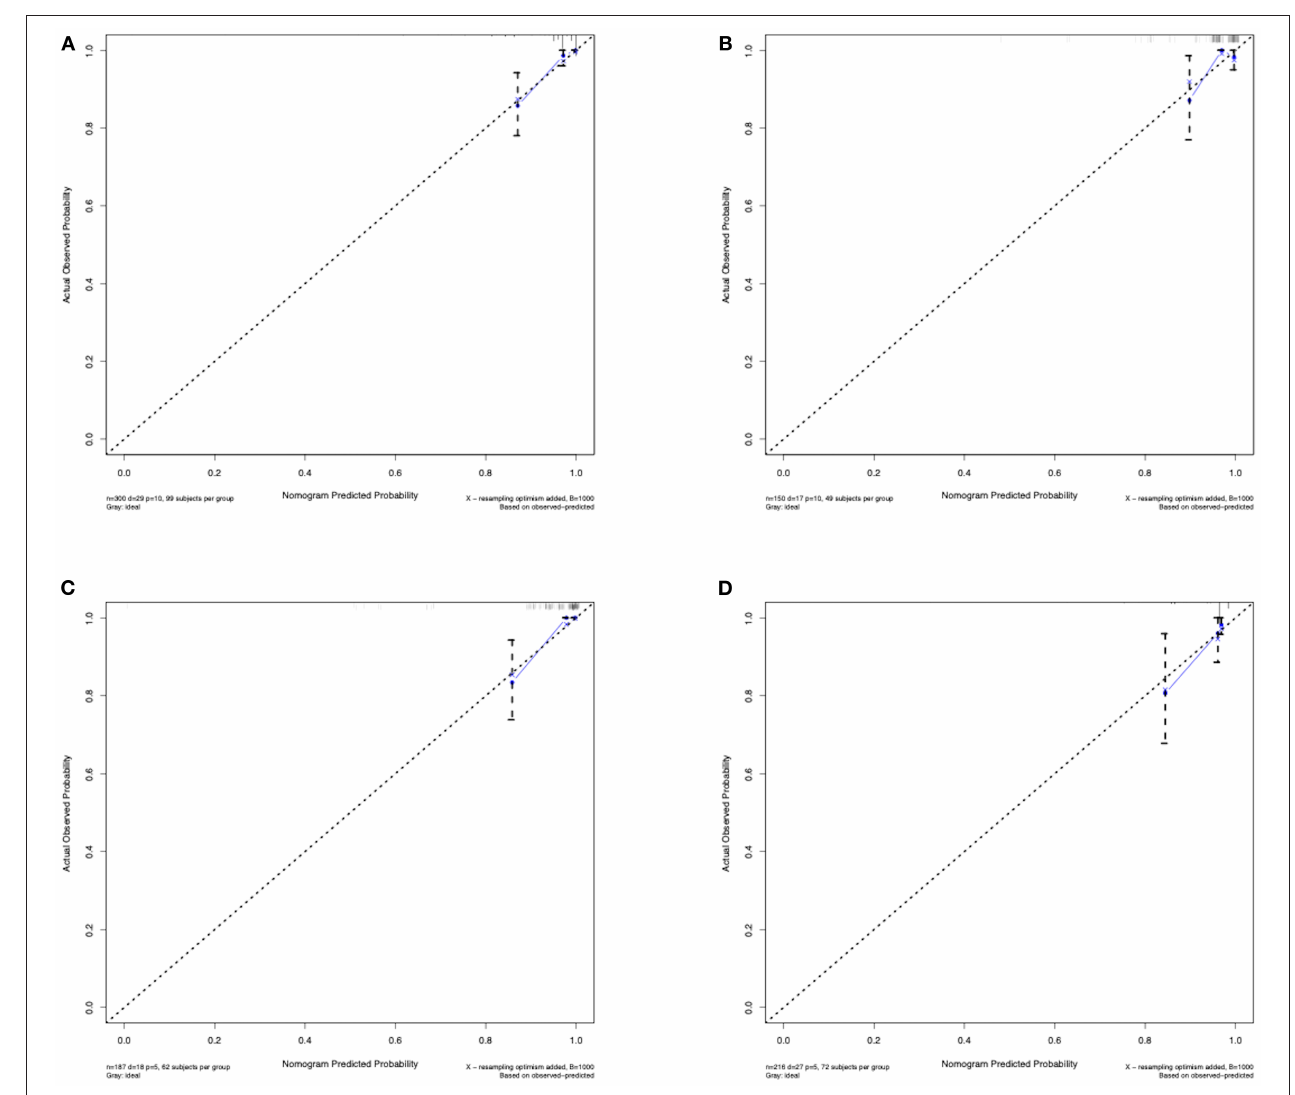
FIGURE 4 | Calibration curves of the predictive nomogram. (A) Calibration curve of the predictive nomogram for 3-year stroke-free survival in the training set. (B) Calibration curve of the predictive nomogram for 3-year stroke-free survival in the test set. (C) Calibration curve of the predictive nomogram for 3-year stroke-free survival in the ischemic-type group. (D) Calibration curve of the predictive nomogram for 3-year stroke-free survival in the hemorrhagic-type group. Calibration curves depict the calibration of each model in terms of the agreement between the predicted risks of future stroke and observed outcomes of future stroke. The x-axis represents the predicted future stroke risk. The y-axis represents the actual observed rate of future stroke. The diagonal dotted line represents a perfect prediction by an ideal model. The solid line represents the performance of the nomogram, where a closer fit to the diagonal dotted line represents a better